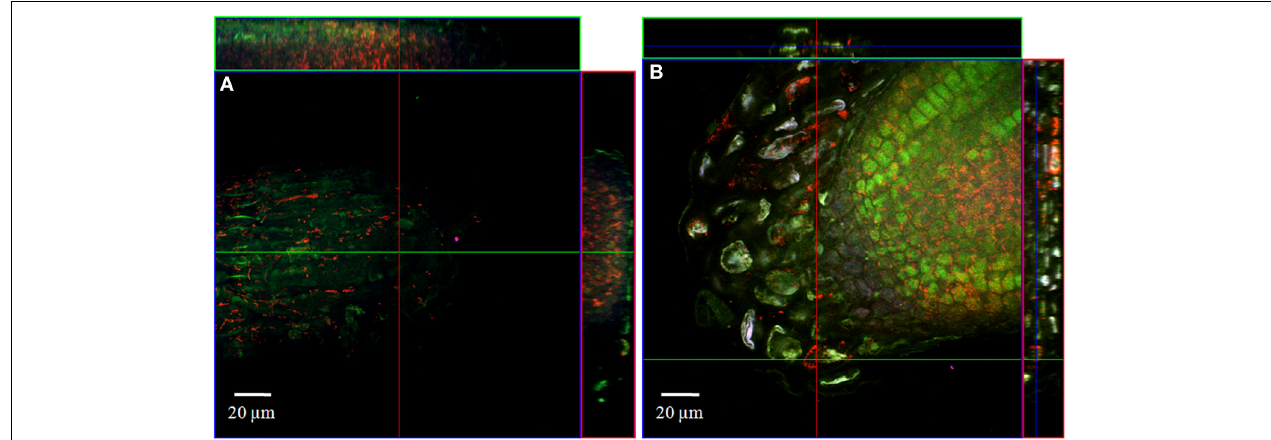
axenic system. Probe Cy3 marked EUB-338, I, II, III was applied during FISH procedures (red signal). The images show (A) surface colonization and (B) glycocalix colonization of the root tips.